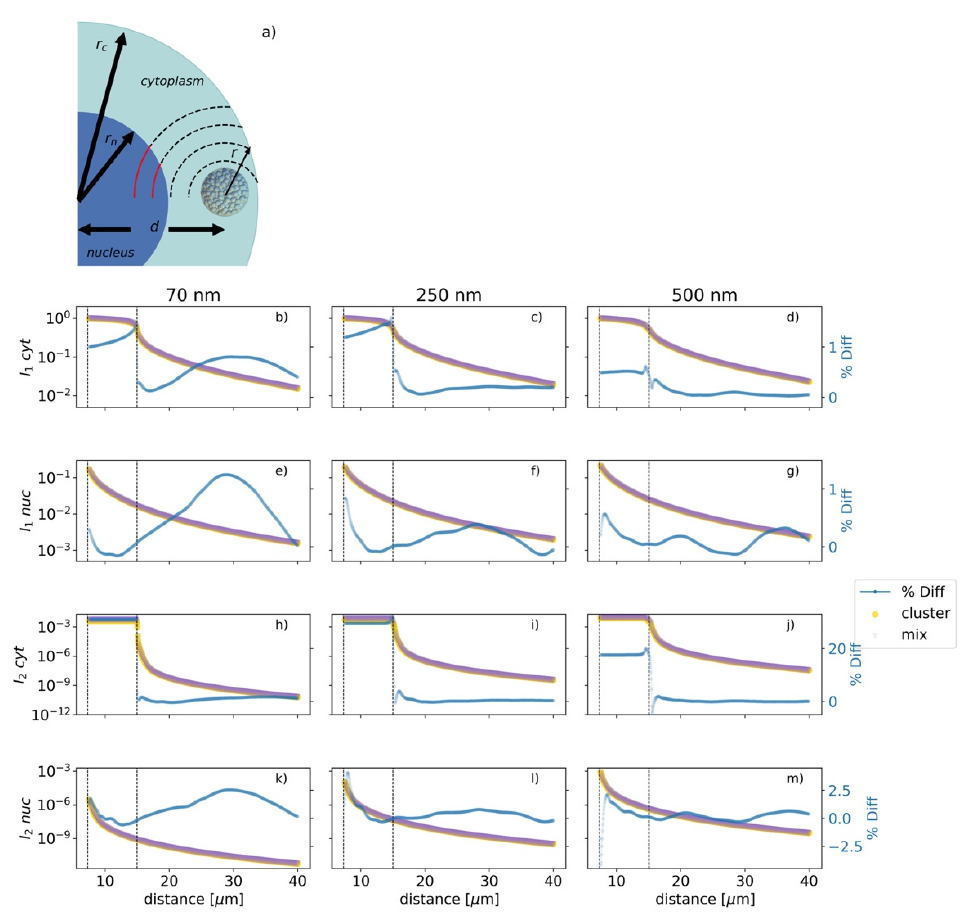
Figure 4. ( a ) The cell used in this work was modelled as an outer and an inner sphere representing the cytoplasm and nucleus, with radii of r c = 15 and r n = 7 µm, respectively. The cluster/MixNP was placed at different positions d from the center of the cell for the evaluation of I 1 and I 2 for all cluster sizes. ( b – d , e – g ) show I 1 for a MixNP and a full cluster along with the %Diff between them when considering the cytoplasm and the nucleus as V sen s , respectively. ( h – j , k – m ) describe I 2 for a MixNP and a full cluster as well as the %Diff between them when considering the cytoplasm and the nucleus as V sens , respectively. All the curves in the same column are normalized with respect to the I 1 cyt for the cluster of GNPs. The two black dotted lines correspond to the distances of 7.5 and 15 µm.